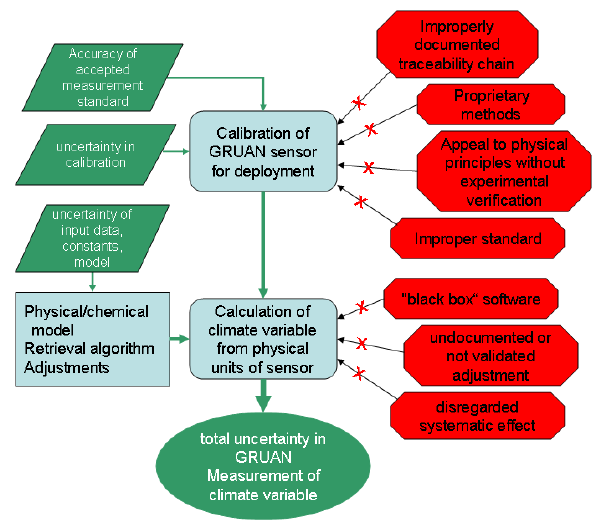
Fig. 2. Schematic for establishing reference quality. Reference data must be traceable to an accepted standard. The red boxes contain components jeopardizing traceability. The procedure establishing traceability and determining the uncertainty must be transparent and reproducible.